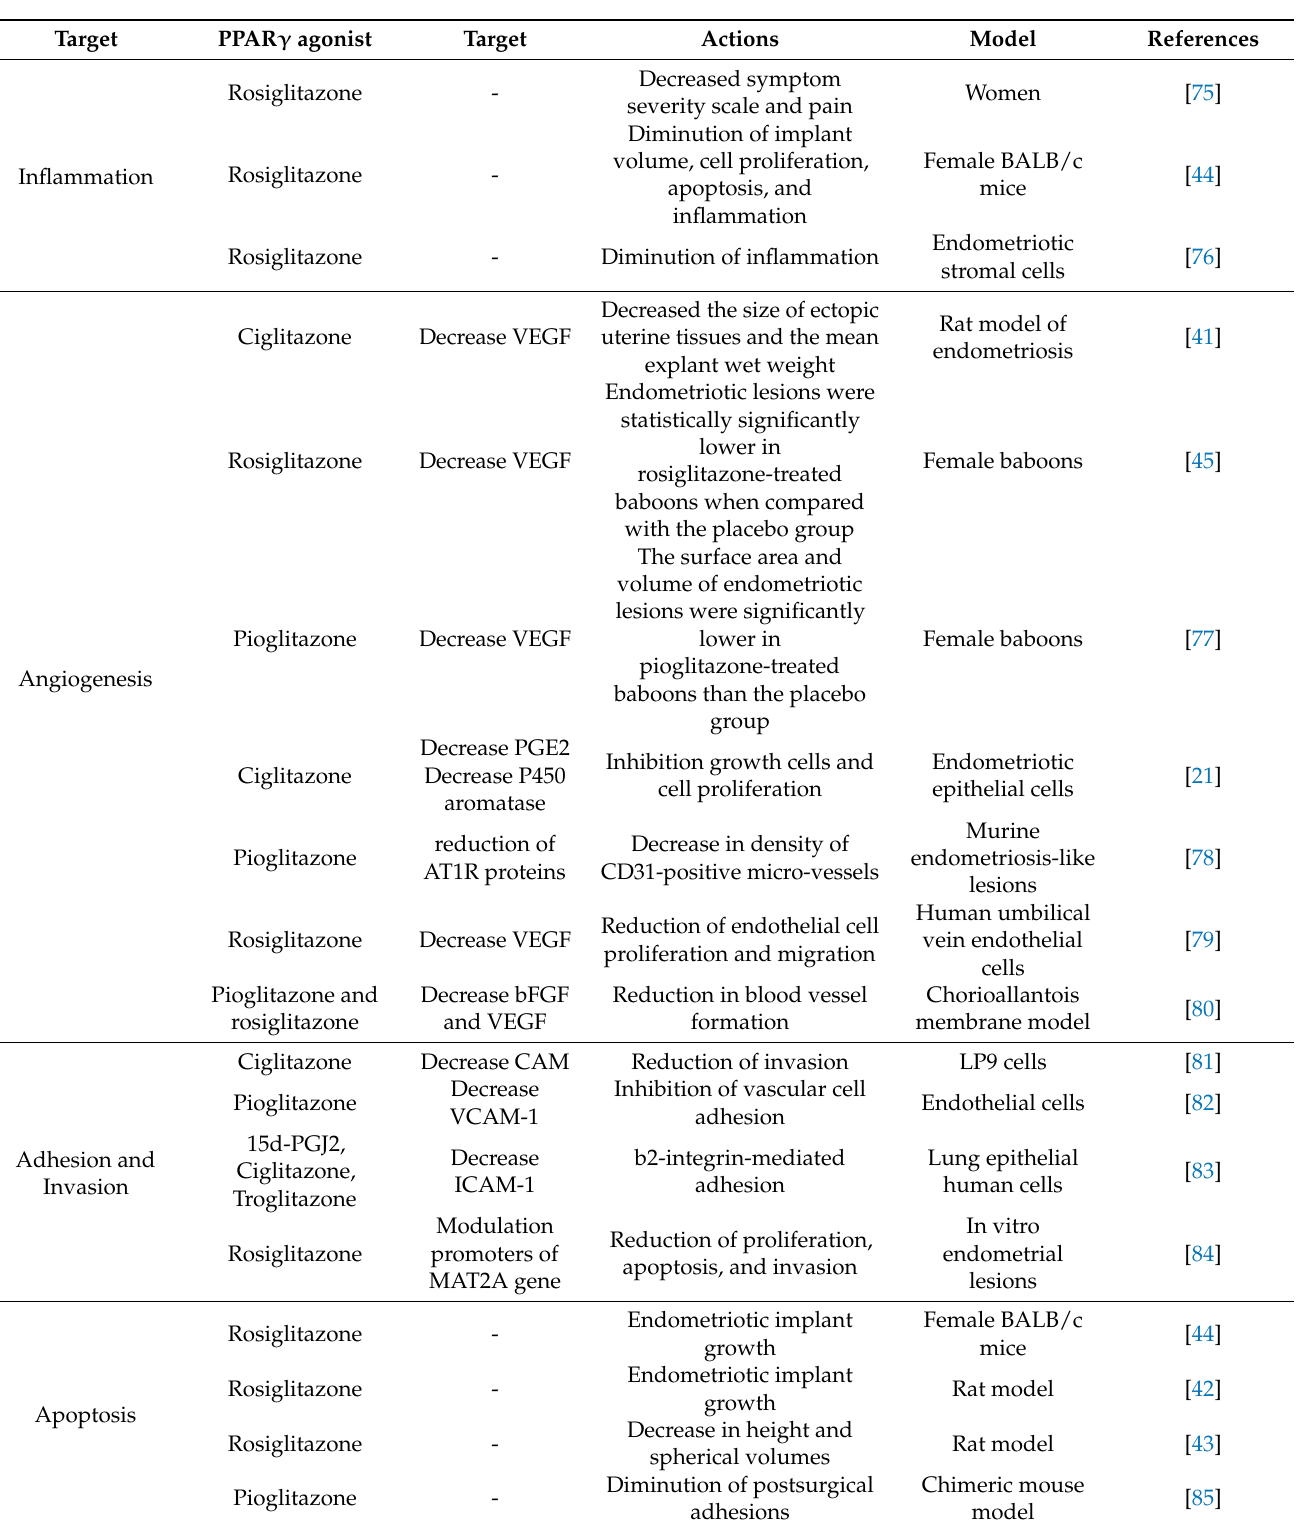
Table 1. Mechanisms by which PPAR γ agonists modulate inflammation, angiogenesis, adhesion and invasion, and apoptosis in